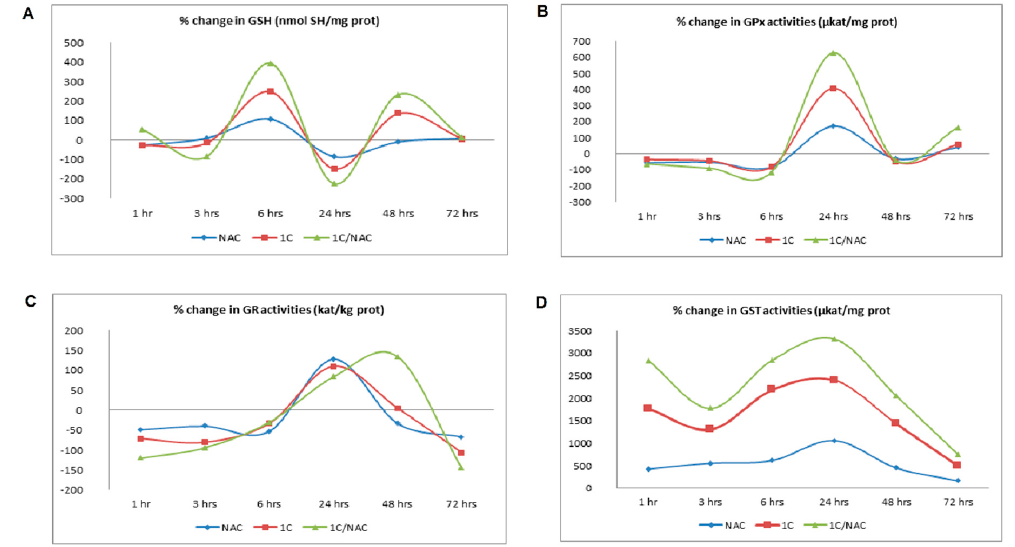
Figure 3. Oxidative DNA damage detection using 8-oxo-7,8-dihydroguanine (8-oxoG) level measurement after 24, 48, and 72 h incubation of HCT116 cells with 1C and NAC / 1C. Significantly different c p < 0.001 vs. untreated cells (control); ** p < 0.01, *** p < 0.001 vs. 1C.